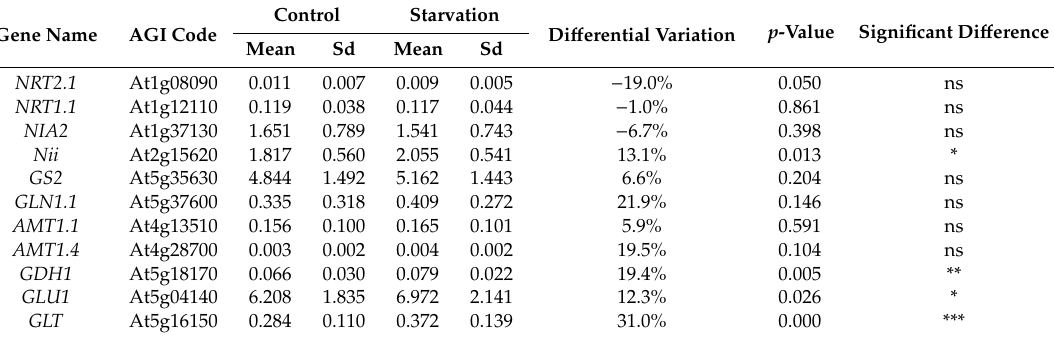
Figure 1. ANOVA of transcript abundance variation for N metabolism-( A ) and autophagy-( B ) related genes among the Arabidopsis accessions. Models are adjusted within are tested an experiment repeat effect (Experiment), a nutrition effect (Nutrition), a genotype effect (Genotype), a genotype by nutrition interaction factor (G × N) and residual error (Residual). Only significant effects are showed ( p < 0.05). Table 1. Averages on all accessions of di ff erential gene expression between the control and starvation